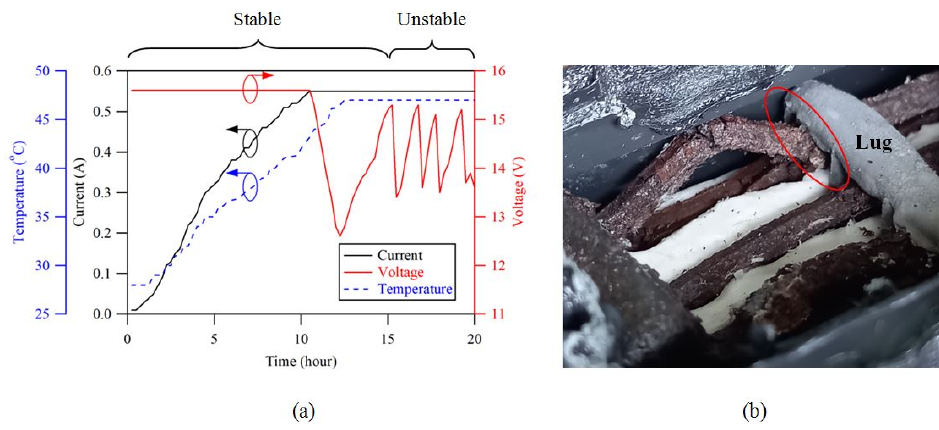
Figure 7. Scenario three: ( a ) charging response of the short-circuited batteries when charging at 15.6 V; ( b ) an expanded positive grid short with the negative lug.